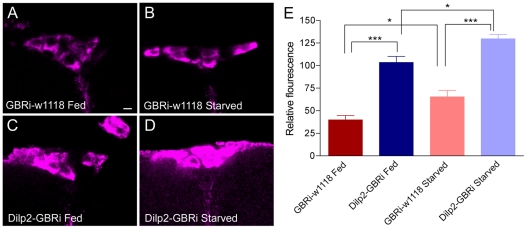
GABAB receptor knockdown on insulin-producing cells affects DILP levels.
A. Relative DILP immunofluorescence in IPCs in fed and starved flies with and without GABAB receptor knockdown (GBRi) in IPCs (Dilp2-Gal4/UAS-gbr2-RNAi). The DILP antiserum used is likely to cross react with DILP2, 3 and 5 [16]. Control flies (GBRi-w1118) display significantly lower levels of DILP-immunofluorescence than the flies with GBRi (Dilp2-GBRi), both in fed flies (p<0.001; Anova with Tukey's comparison) and after starvation (p<0.001). A smaller, but significant, increase in DILP fluorescence is seen at starvation for both genotypes (p<0.05 in both cases). 19–35 cells were measured in 5 specimens of each genotype. B–E. representative confocal images of DILP-immunolabeled IPC of the fed and starved control (GBRi-w1118) and experimental (Dilp2-GBRi) flies.